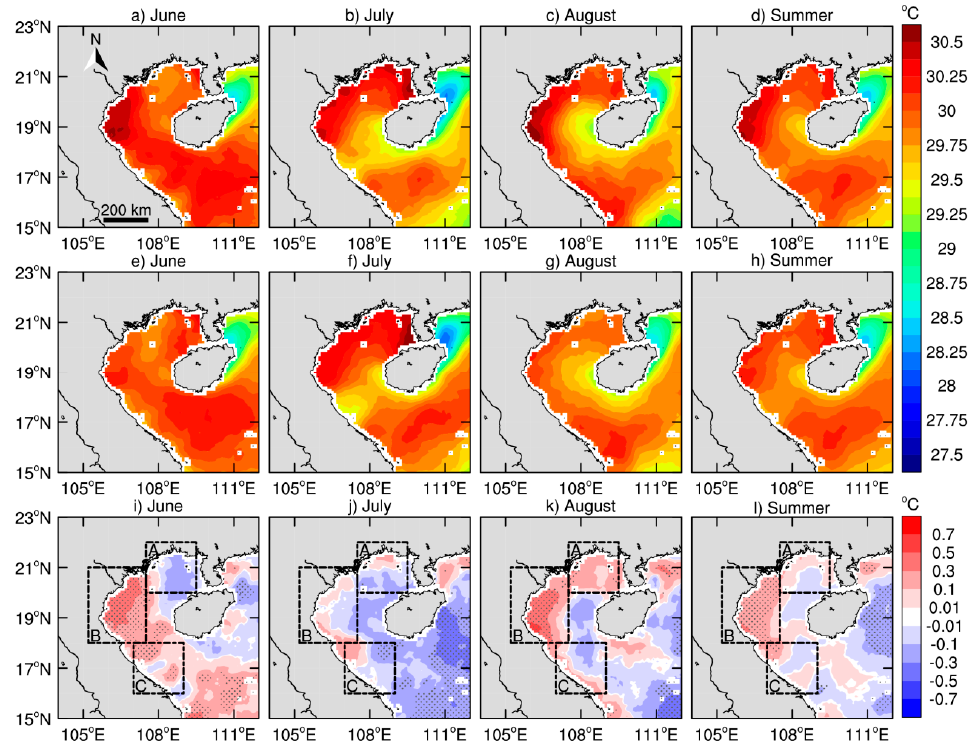
Figure 5. Same as Figure 4 but for the sea surface temperature (SST).